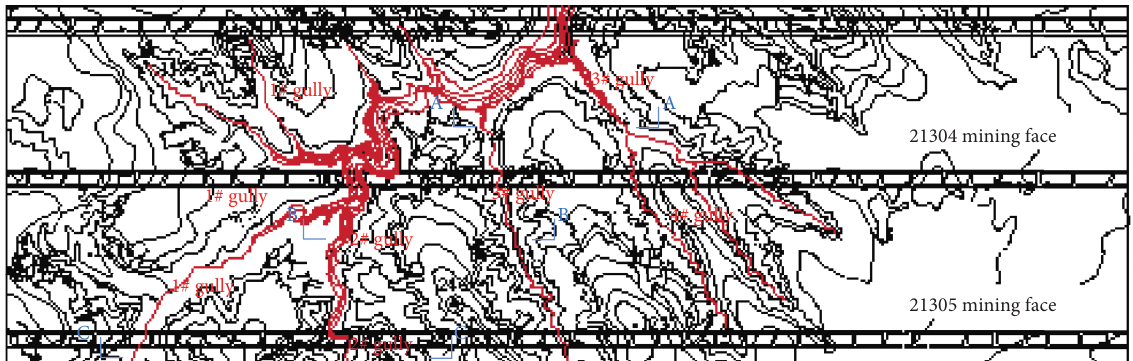
Figure 1: Surface-underground contrast plan of the No. 3 Panel 1 − 2 coal of the Huojitu Coal Mine. Table 1: Pressure features in the working faces of different terrain areas.